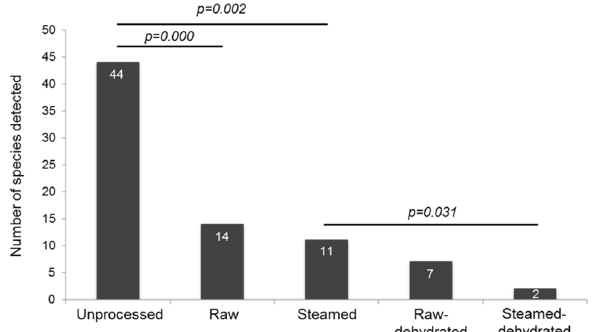
Figure 1. Number of species detected on unprocessed placentas (fetal and maternal side) and processed samples (n = 24) dependent on preparation methods. The tap water contaminant Achromobacter xylosoxidans was discounted.